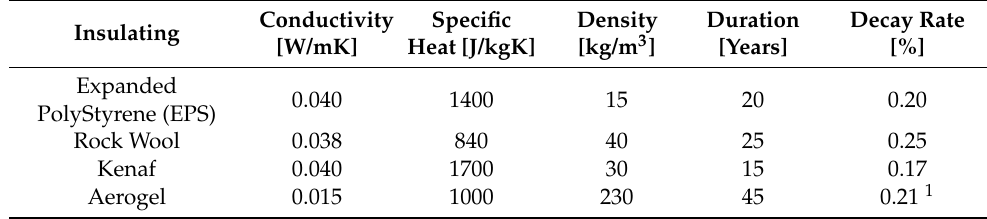
Table 3. Thermal characteristics, duration and decay rate of the aerogel and other materials.